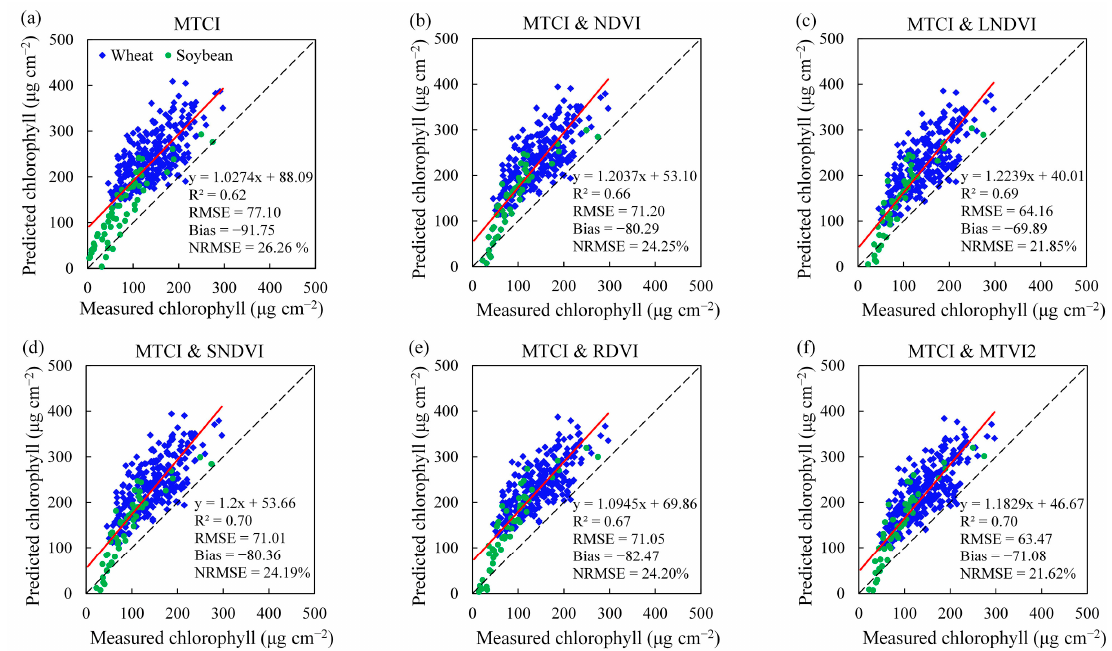
Figure 8. The CCC retrieval accuracy for soybeans and wheat when using the BLR method with field spectrum data: ( b ) MTCI and NDVI; ( c ) MTCI and LNDVI; ( d ) MTCI and SNDVI; ( e ) MTCI and RDVI; ( f ) MTCI and MTVI2. The performance of a single MTCI in a linear regression model is displayed in ( a ) for comparison.